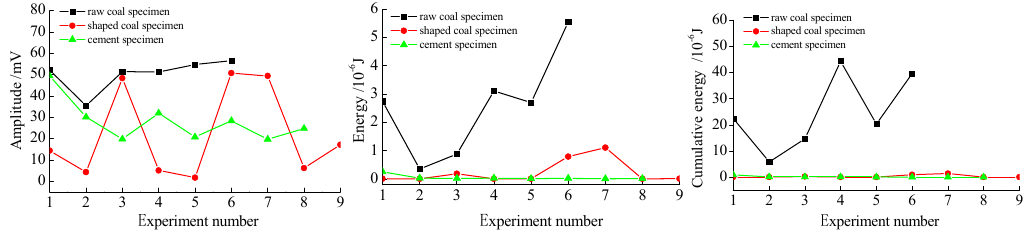
Figure 25. Amplitude, energy and cumulative energy of 2# MS sensors.